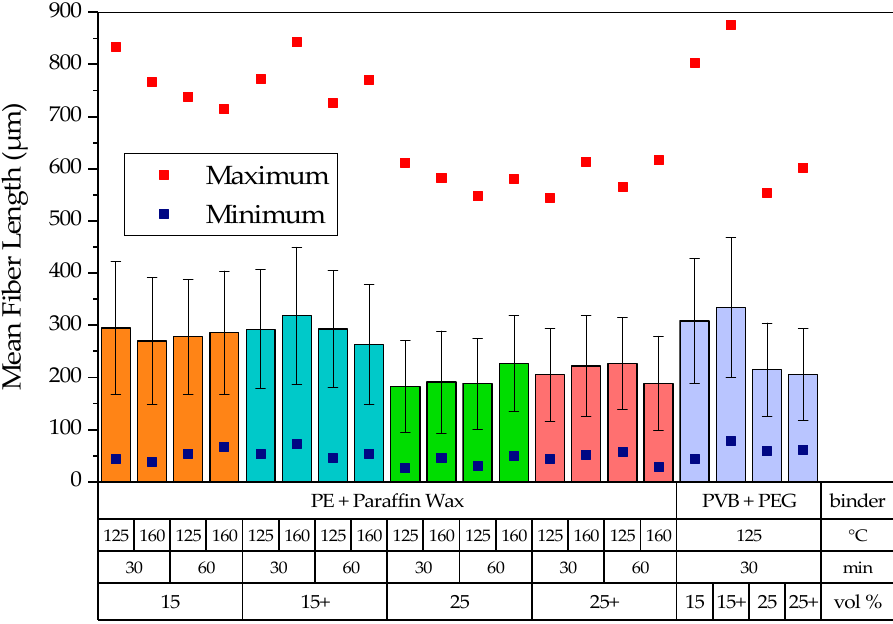
Figure 14. Fiber lengths versus different processing conditions and binding systems.